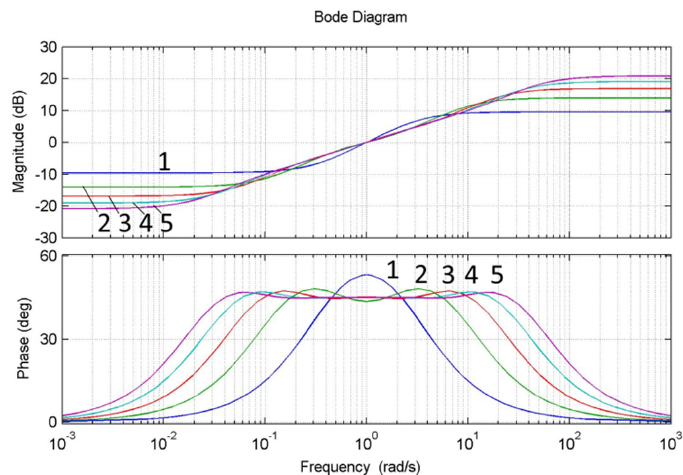
Figure 1. Transition processes of parts (12)—1, (15)—2, (20)—3, (21)—4, (22)—5.